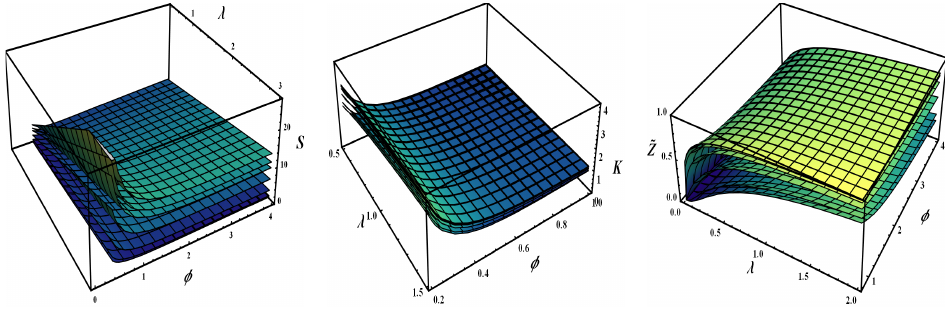
Fig. 4. E⁄ects of skewness and kurtosis of HLUG-TI for certain values of parameters. Figure 4. Effects of skewness and kurtosis of HLUG-TI for certain values of parameters. At various levels of (cid:12) and di⁄erent values of model parameters (cid:30) and (cid:21) , Fig. 4 shows maps of Partition measures can be used to assess the variability of the kurtosis and skewness, kurtosis and median. The model is discovered to be leptokurtic to platykurtic in nature and positively skewed. As (cid:30) and (cid:21) rises, skewness becomes approximately equal to 2.3 at the (cid:133)rst level of (cid:12) . Skewness is higher at lower (cid:30) and higher value of (cid:21): Furthermore distribution peakedness yields higher values at lower (cid:30) and (cid:21) , but as (cid:30) and (cid:21) increase, it ends up to roughly 1.5. Also median yields lower values at lower (cid:30) and (cid:21) , but as (cid:30) and (cid:21) rises, it approaches 1. Partition measures can be used to assess the variability of kurtosis and skewness of Z using